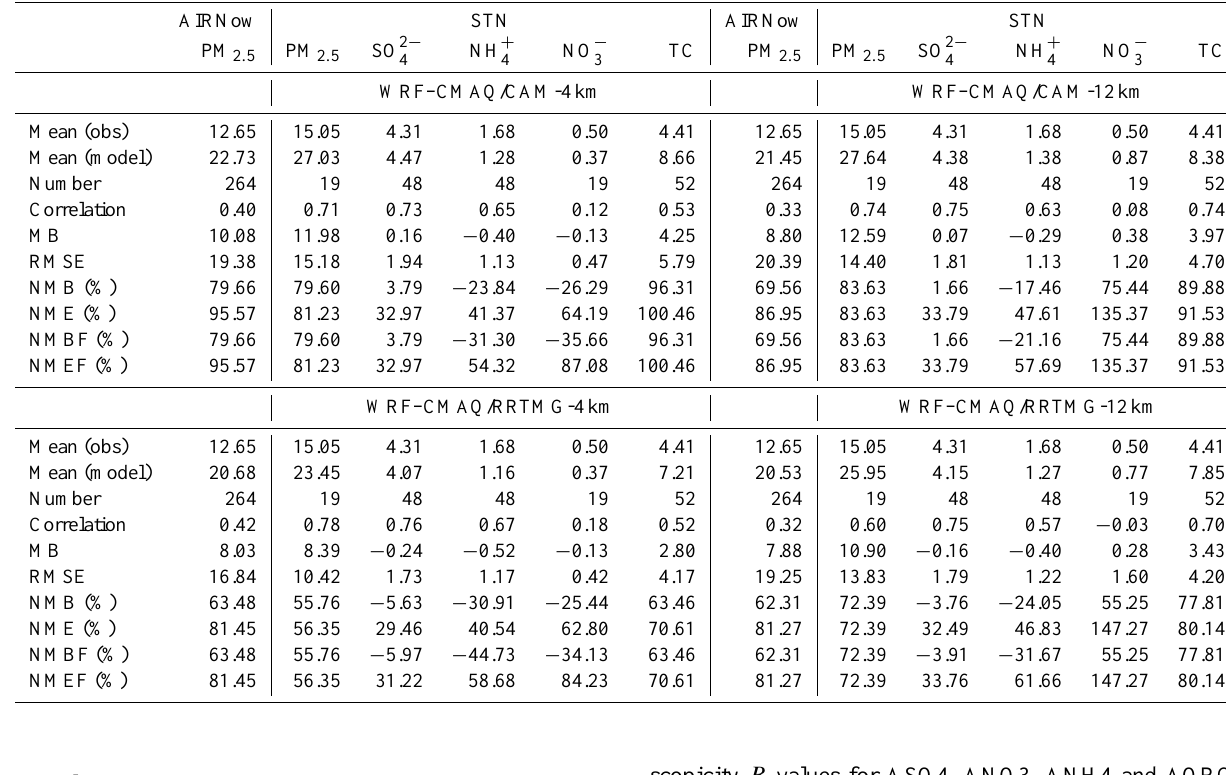
Table 8. The same as Table 6, but for September of